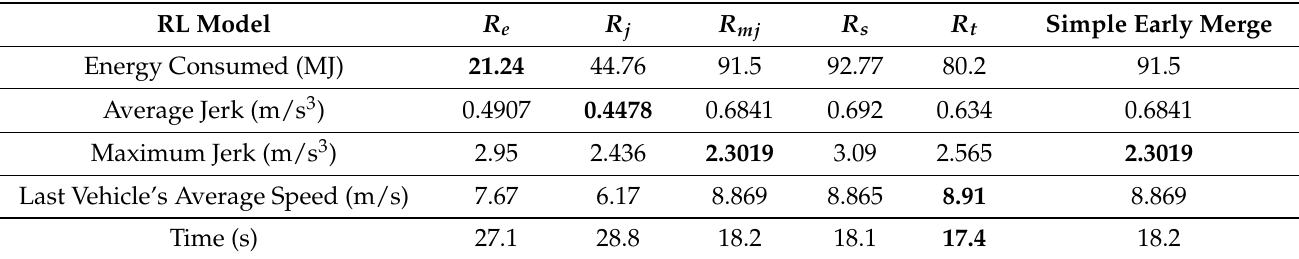
Table 3. Evaluation results of different single objective RL